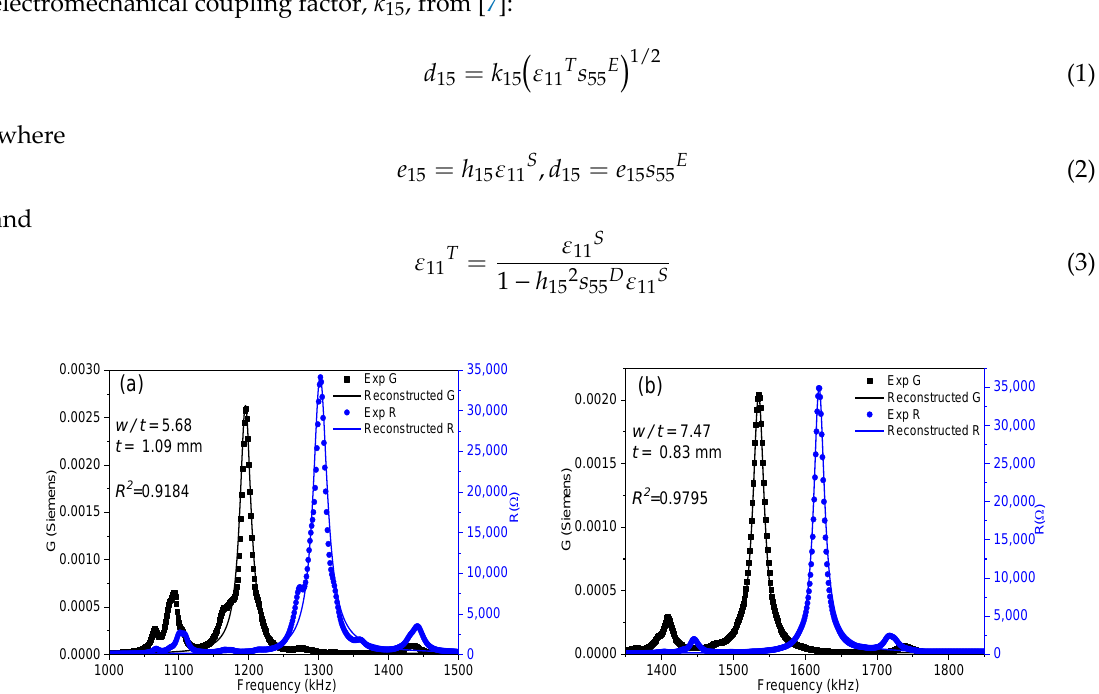
Figure 2. Impedance spectra for the shear mode of the Ba 1-x Ca x Ti 0.90 Zr 0·10 O 3 (BCZT) plate for aspect ratios ( a ) w / t = 5.68; ( b ) w / t = 7.47. Measured G and R peaks (symbols) and reconstructed peaks (solid lines) are displayed.